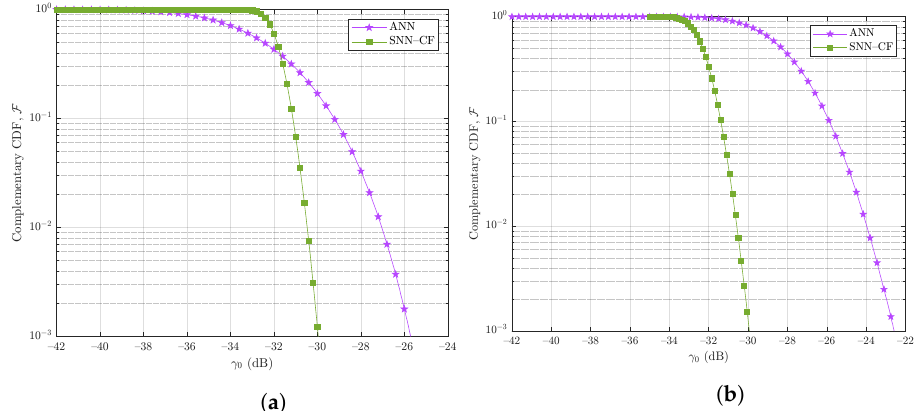
Figure 10. Power leakage performance of the proposed SNN-CF vs. ANN [12] in terms of the reduction achieved in terms of the outband-to-inband power ratio for ( a ) QPSK-OFDM; and ( b ) 16- QAM-OFDM.